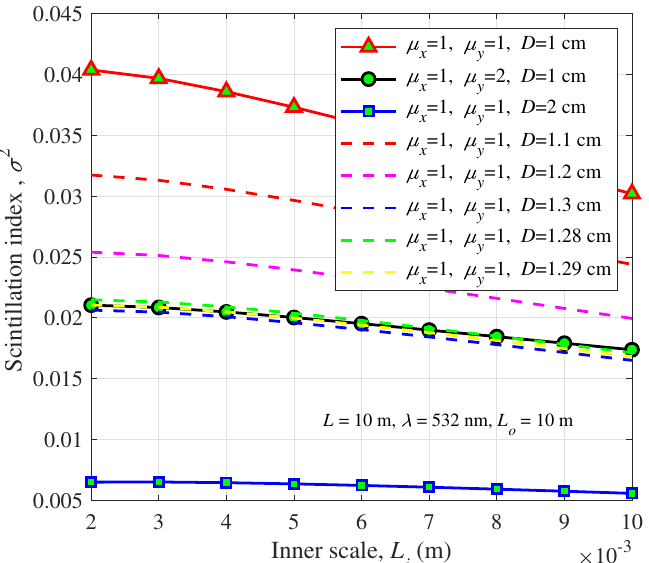
Figure 7. Scintillation index of a spherical wave versus the inner scale under isotropic turbulence for different aperture diameters.